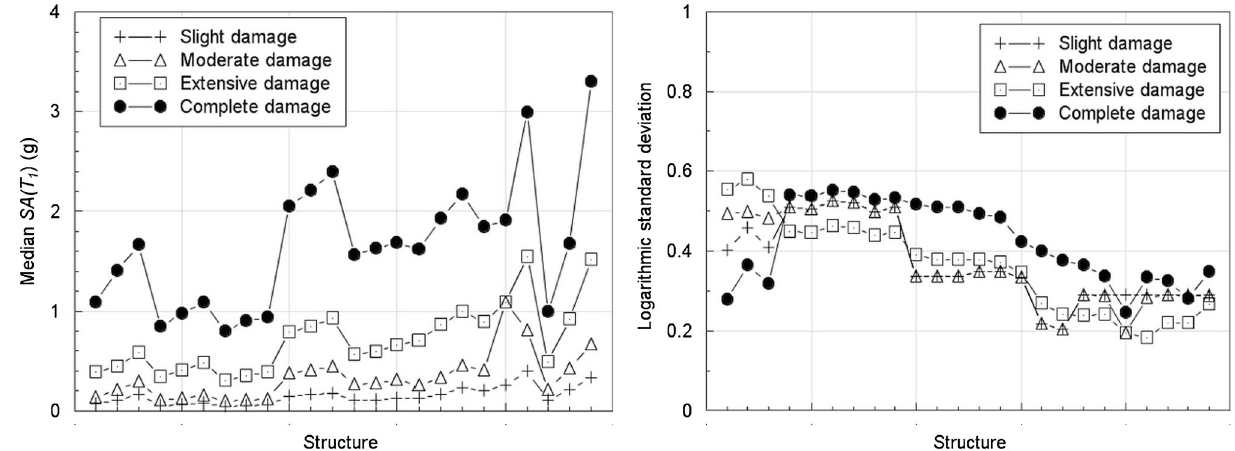
Fig. 7 Median SA(T 1 ) (left plot) and logarithmic standard deviations (right plot) for the fragility curves obtained using SPO2FRAG for structures in Bucharest,